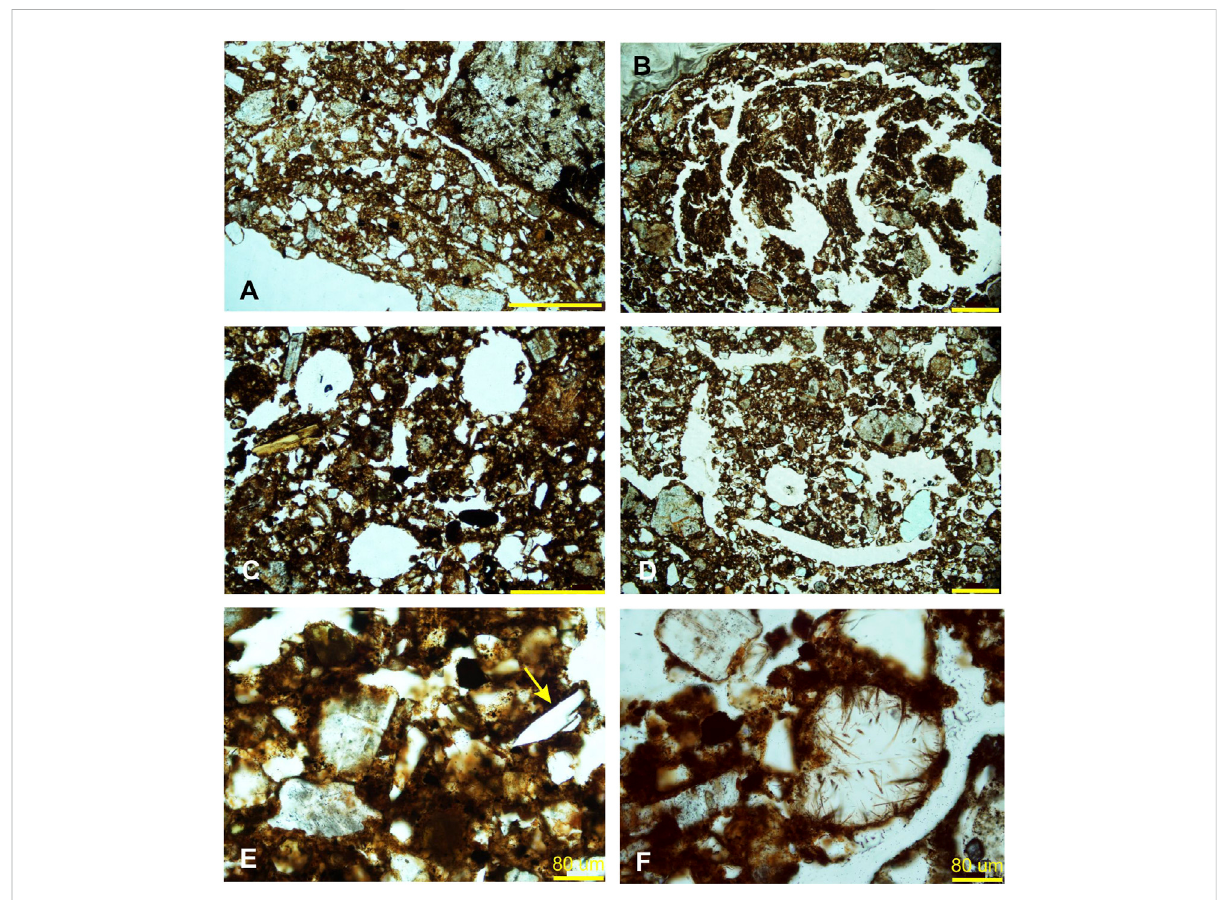
FIGURE 6 Micropictographs of depositional and post-depositional features observed in the Old Geos pro fi le, including (A) rare remnant sedimentary crusts, (B) rotated fabric from faunal activity, (C) open channel voids in amongst dense excremental fabric, (D) collapsed channel feature, (E) quartz shard, and (F) rutilic quartz grain. Yellow scale bar is 600 µm unless otherwise